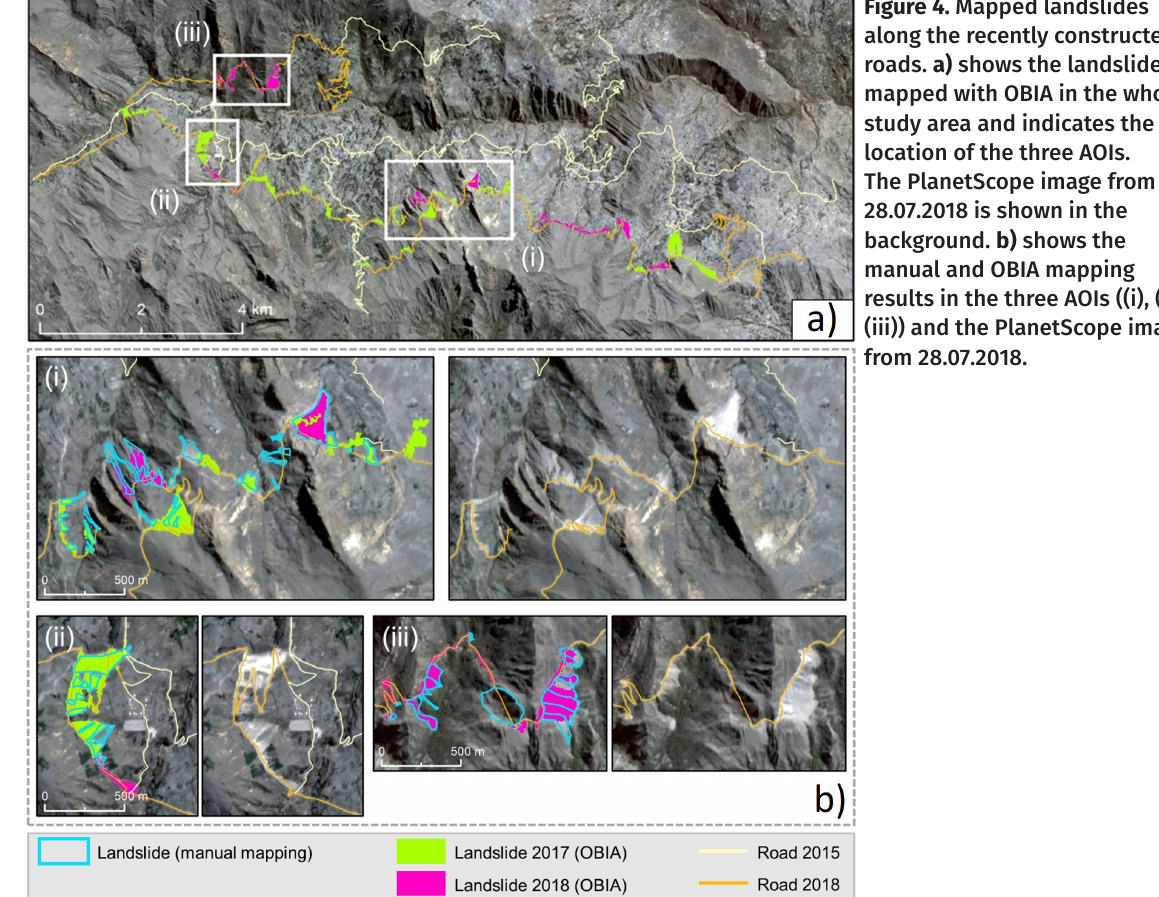
Figure 4. Mapped landslides along the recently constructed roads. a) shows the landslides mapped with OBIA in the whole study area and indicates the location of the three AOIs. The PlanetScope image from 28.07.2018 is shown in the background. b) shows the manual and OBIA mapping results in the three AOIs ((i), (ii), (iii)) and the PlanetScope image from